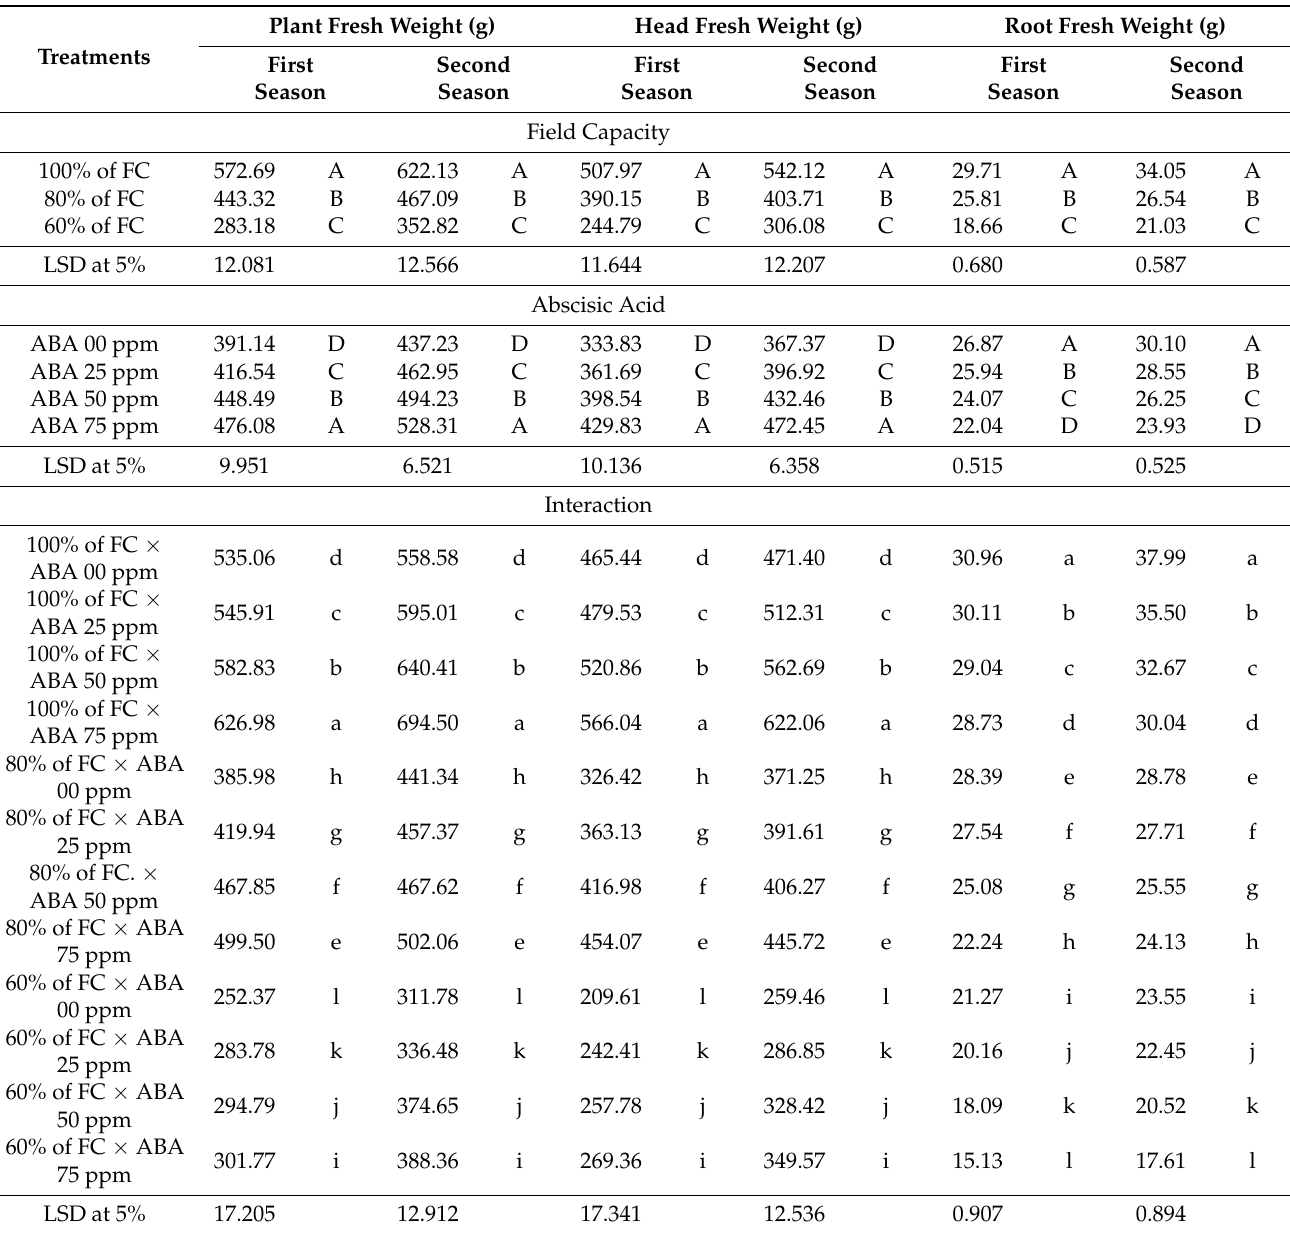
Table 3. Effect of water stress and abscisic acid on plant fresh weight, head fresh weight, and root fresh weight of red cabbage plants (2021–2022